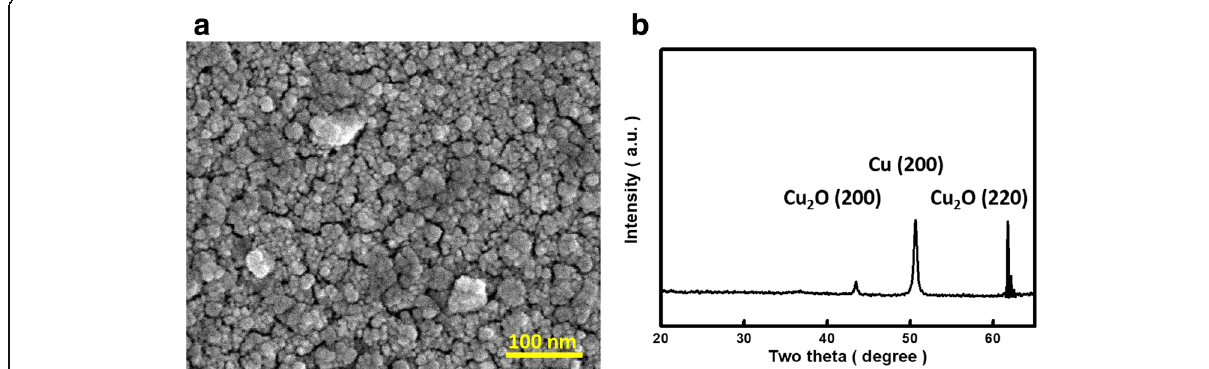
Fig. 3 a Top-view SEM image and b XRD pattern of planar Si substrates coated with Cu 2 O